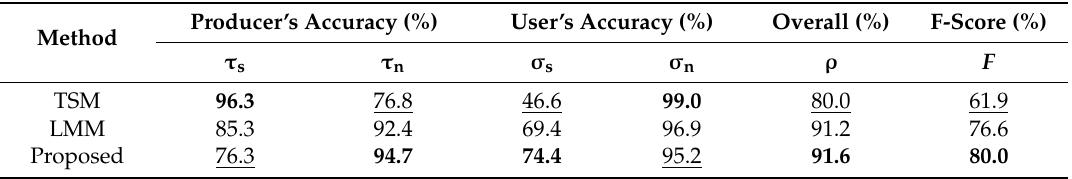
Table 7. Shadow detection accuracy measurements of test 3.